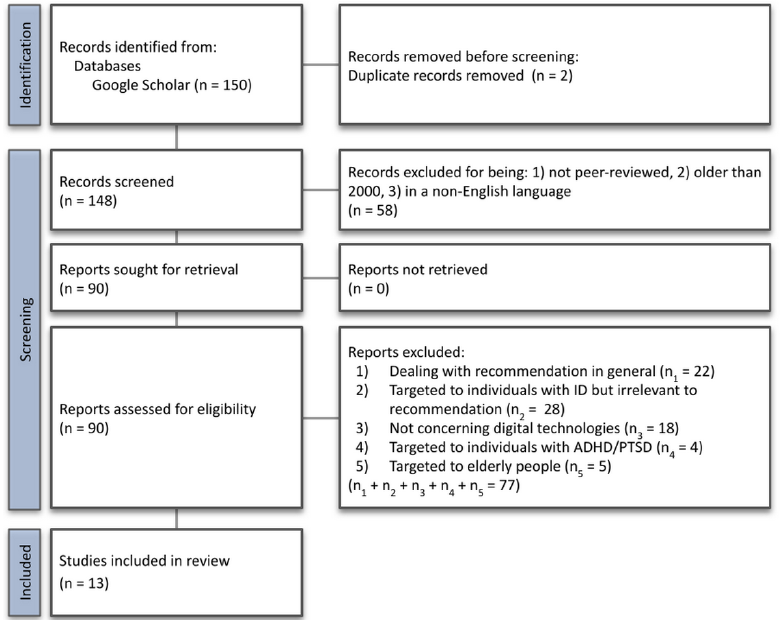
Figure 1. Our methodology for searching the literature for works that deal with recommendations to individuals with ID.